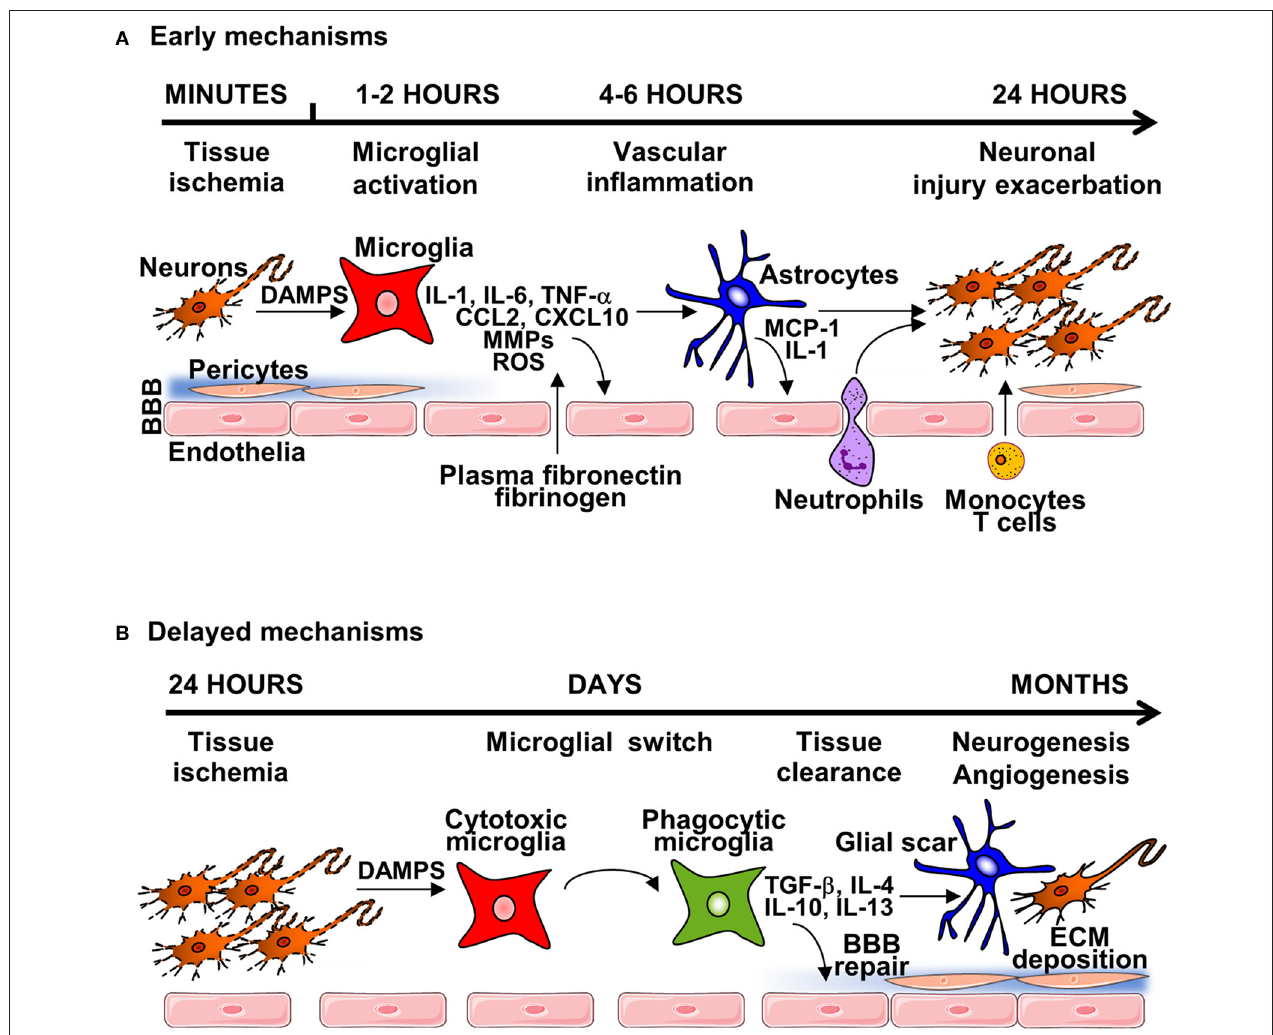
FIGURE 1 | The general mechanisms of neuroinflammation post-stroke. (A) Early mechanisms of neuroinflammation are initiated by acute neuronal injury producing DAMPS, leading to microglial and endothelial cell activation and disruption of the BBB, through release of pro-inflammatory cytokines, chemokines, reactive oxygen species (ROS) and matrix-metalloproteinases (MMPs). Degradation of the extracellular matrix (ECM)—in both the parenchyma and basement membrane induces astrocyte endfeet and pericytes lifting from the endothelium. Damage of the BBB enables infiltration of circulatory cells with transmigration of neutrophils and immune cells. This damage can lead to brain oedema and hemorrhage, causing further neuroinflammation and tissue damage. (B) During the subacute phase of injury, microglial switch from cytotoxic to phagocytic phenotype occurs, leading to tissue clearance, and expression of anti-inflammatory mediators and neurotrophic factors that leads to the formation of the glial scar, and initiation of brain repair mechanisms, including neurogenesis, angiogenesis and BBB